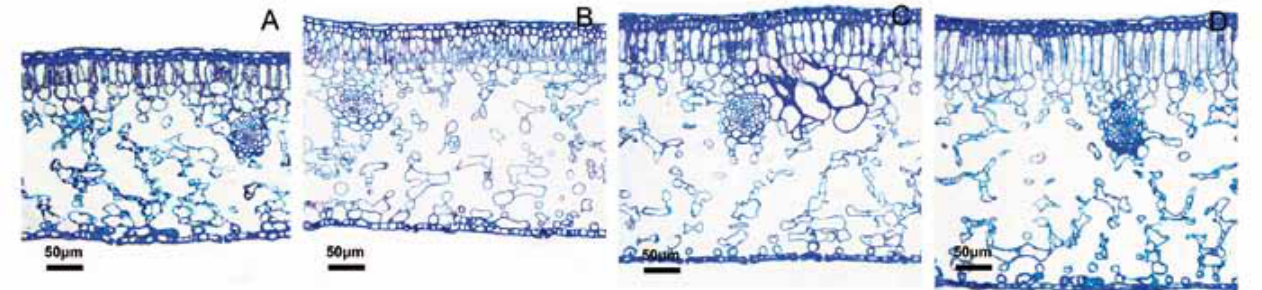
Fig. 3: Light micrographs of characteristic semi-thin cross-sections in the leaves of M. breviracema at different light intensities. I 10 (A), I 30 (B), I 50 (C), I 100 Tab. 2: Changes in number of mesophyll chloroplast (n mm -2 ) and structural characteristics of chloroplast in leaves of M. breviracema in various light conditions.